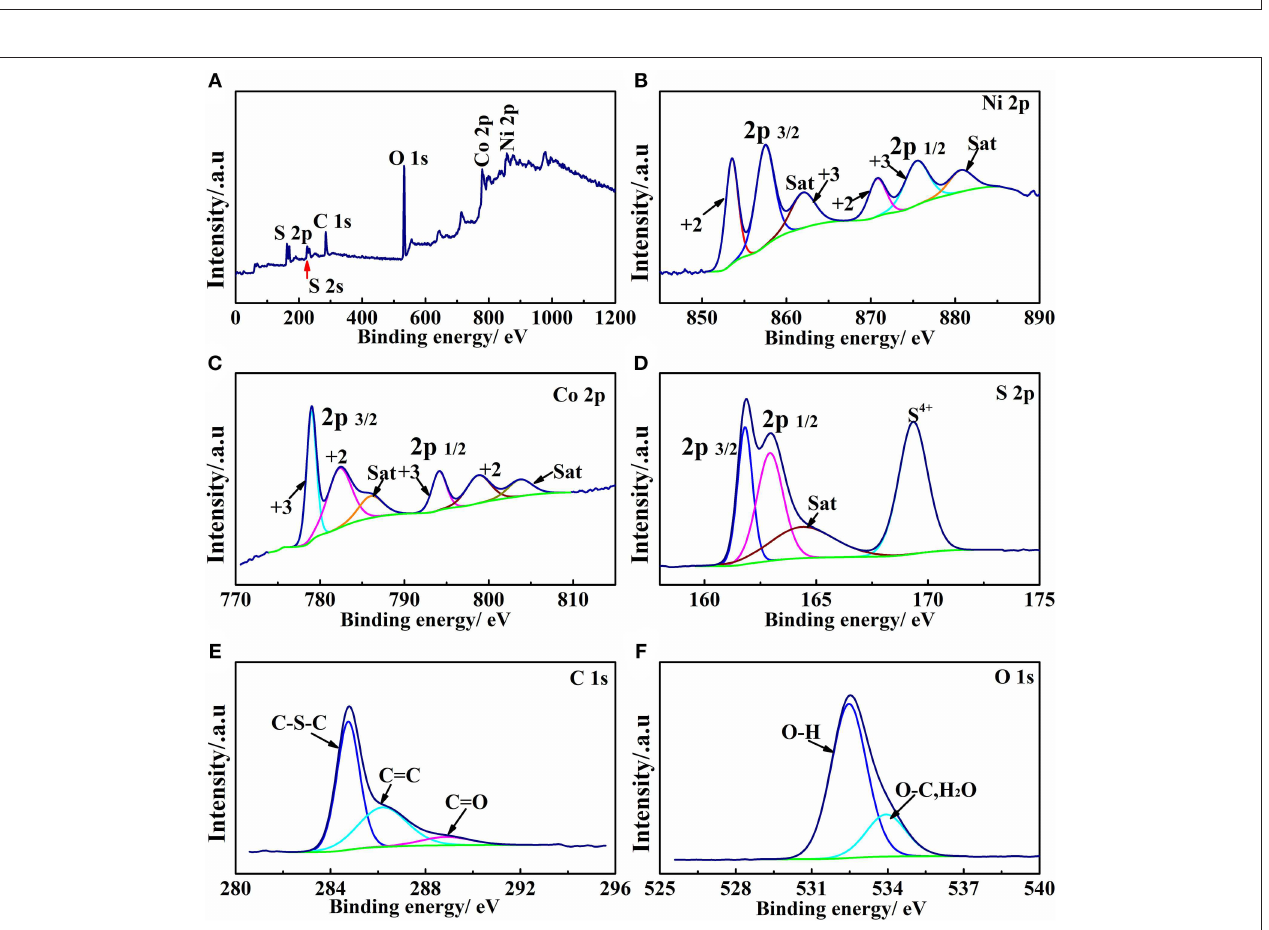
FIGURE 3 | XPS spectrum of Ni 1.64 Co 2.40 S 4 /rGO composite: survey scan (A) , High-resolution spectra of Ni 2p (B) , Co 2p (C) , S 2p (D) , C 1s (E), and O 1s (F) , respectively.